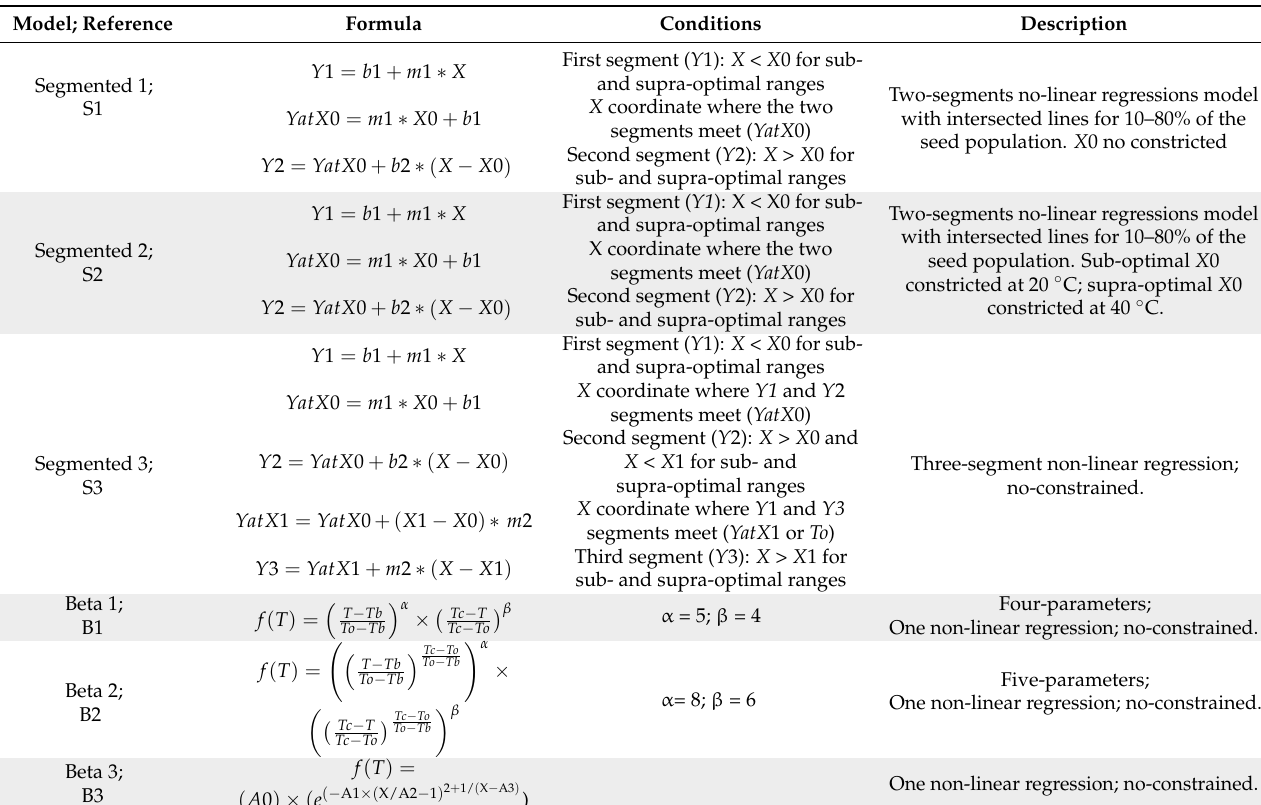
Table 2. Non-linear regression models fitted to reciprocal of GR versus temperature data for 10–80% percentiles to determine cardinal temperatures of chia